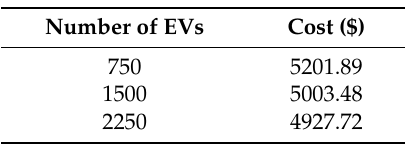
Table 3. Changes of operation costs with various numbers of